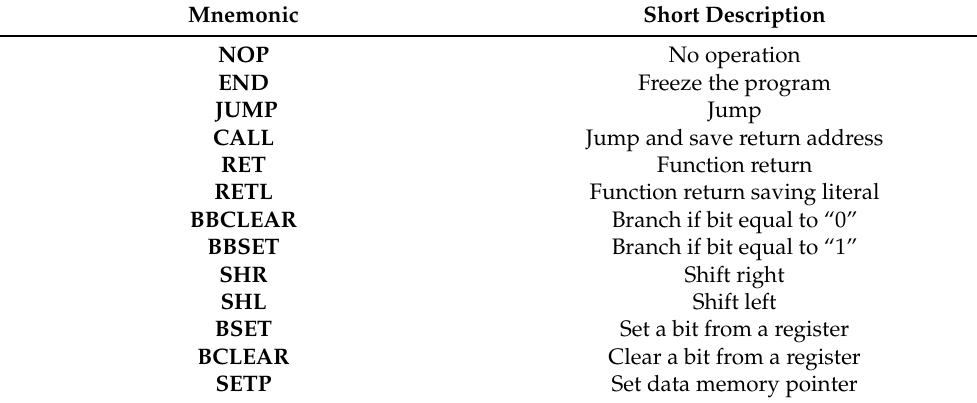
Table 1. Basic instruction subset.